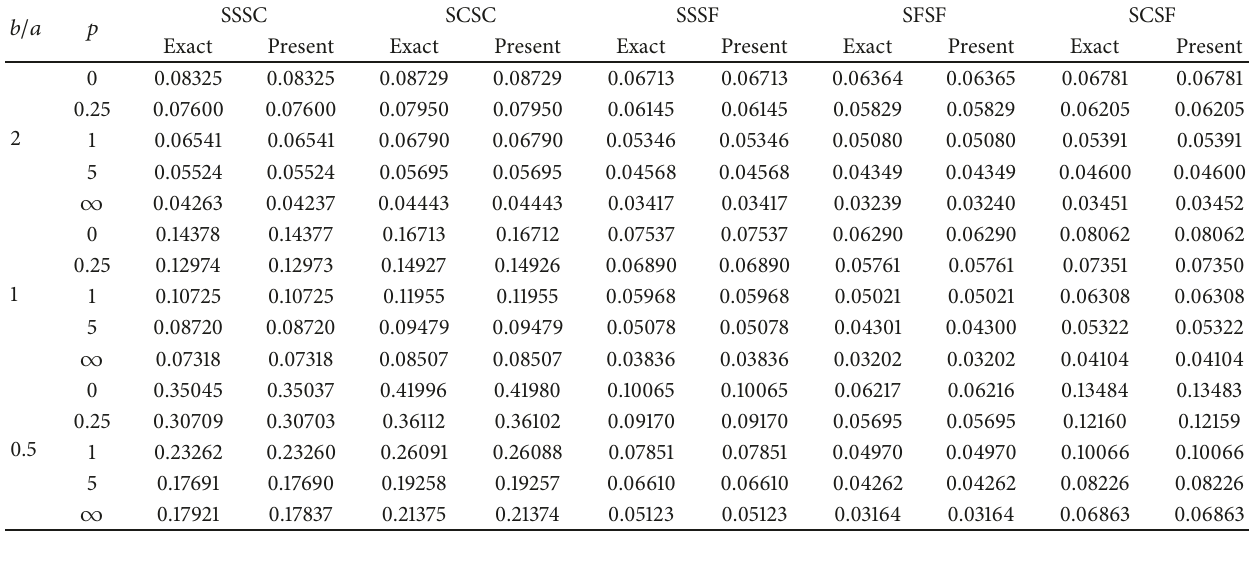
Table 9: Comparison of fundamental frequency parameter Ω = 𝜔ℎ(𝜌 𝑐 /𝐸 𝑐 ) 1/2 for Al/Al 2 O 3 plates when ℎ/𝑎 = 0.15 .